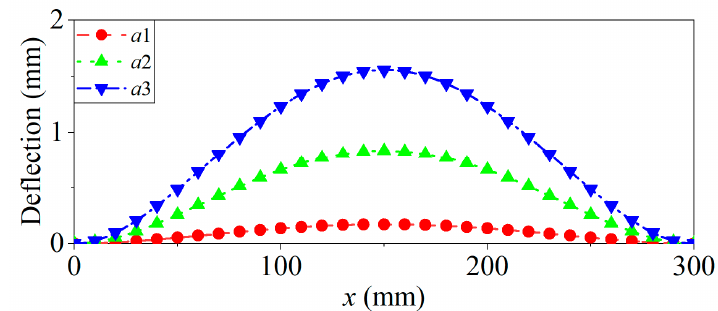
Figure 3. Deflections of beams under different static loads. Figure 3. De fl ections of beams under di ff erent static loads.